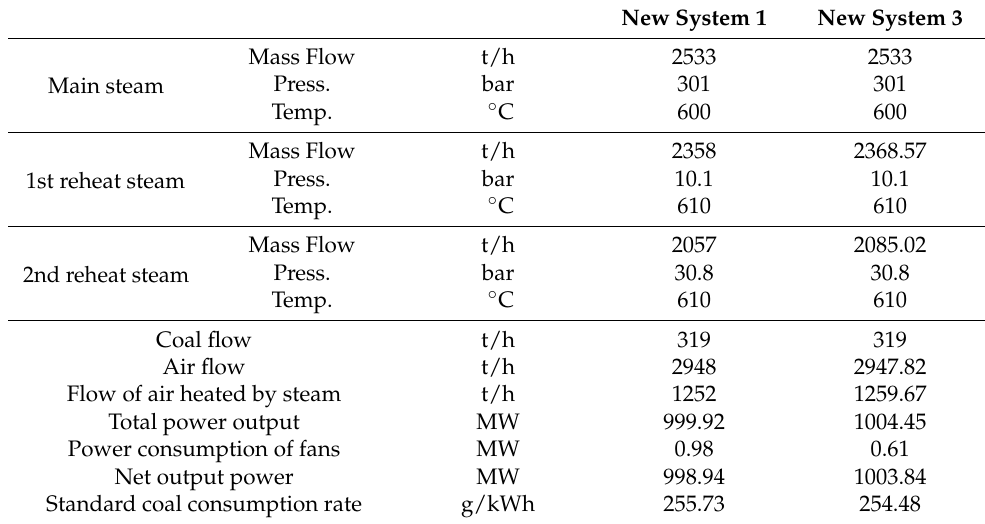
Table 4. Comparison of main performance parameters of new system 1 and new system 3.